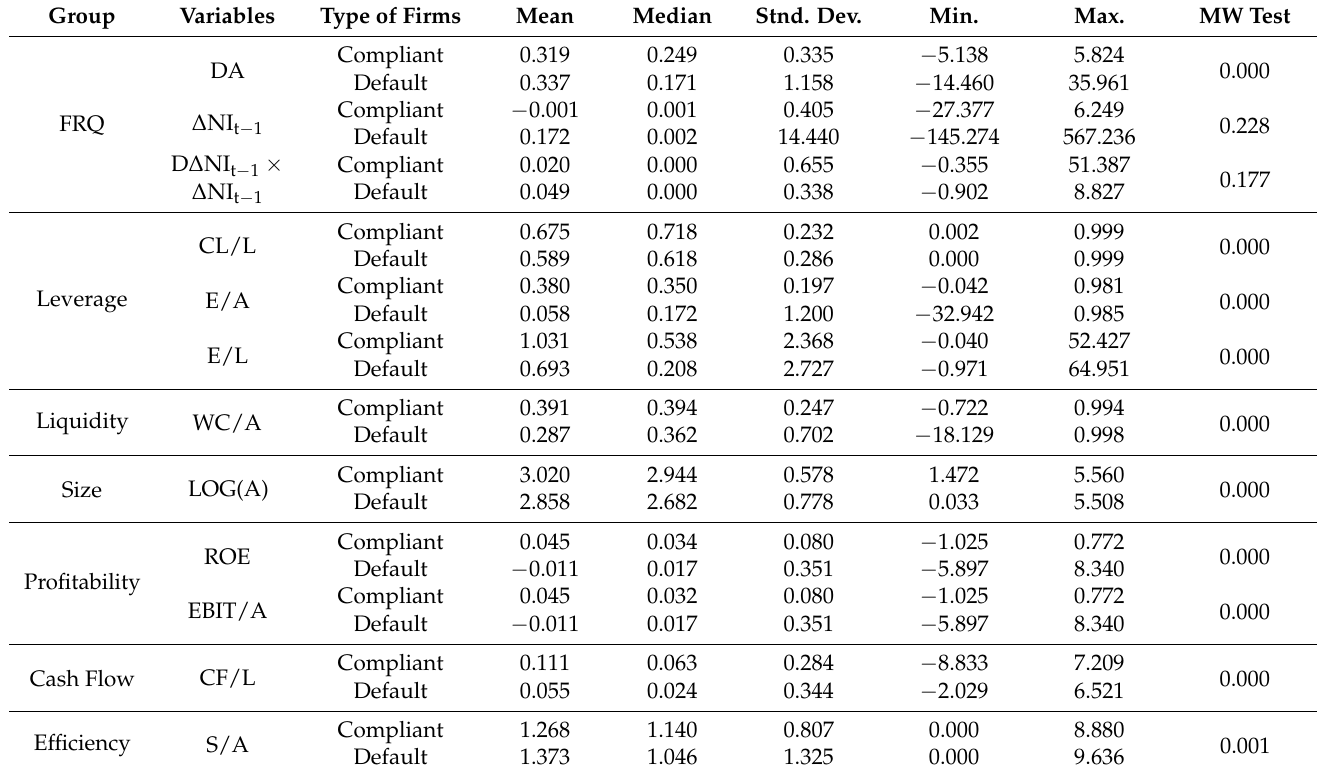
Table 3. Descriptive